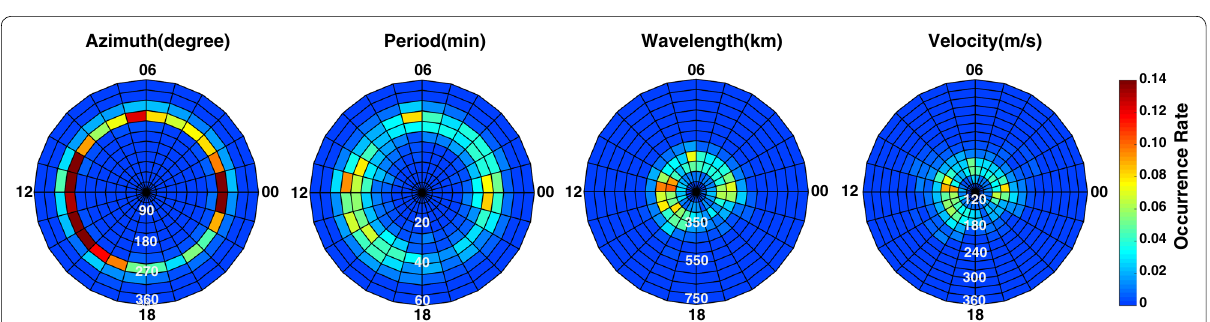
Fig. 9 LT variations in the propagation parameters of MSTIDs during the cyclone